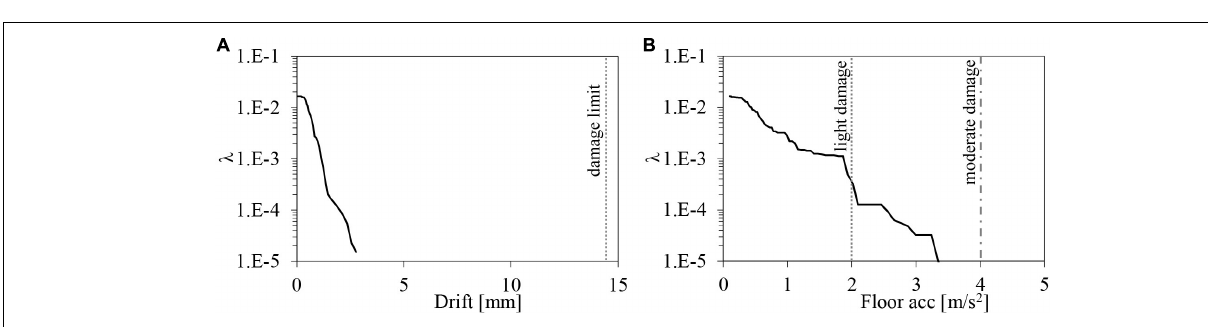
Frontiers in Built Environment |